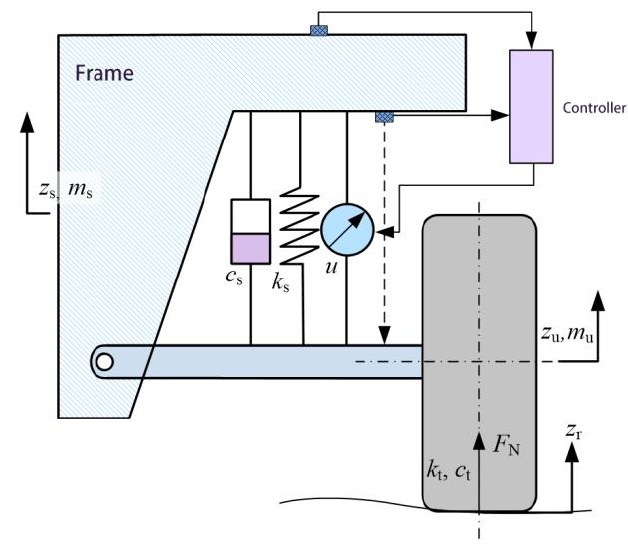
Figure 1. Quarter car suspension model.